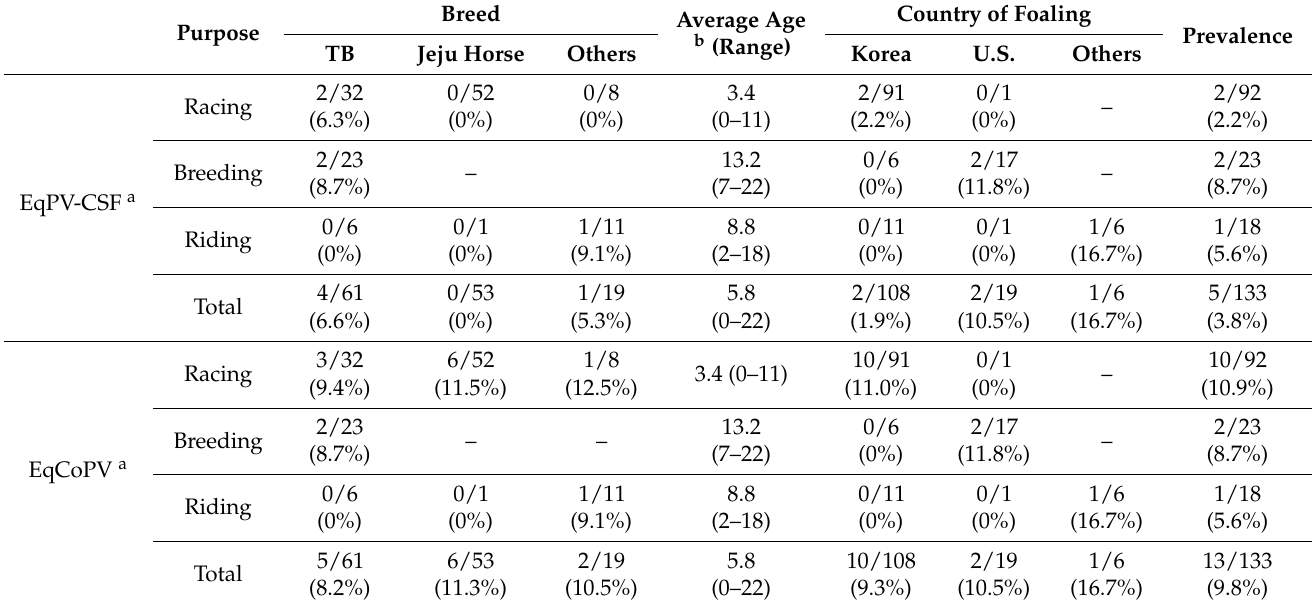
Table 1. Detailed information regarding the purpose, breed, country of foaling, age, and prevalence of EqPV-CSF/EqCoPV in serum among horses in